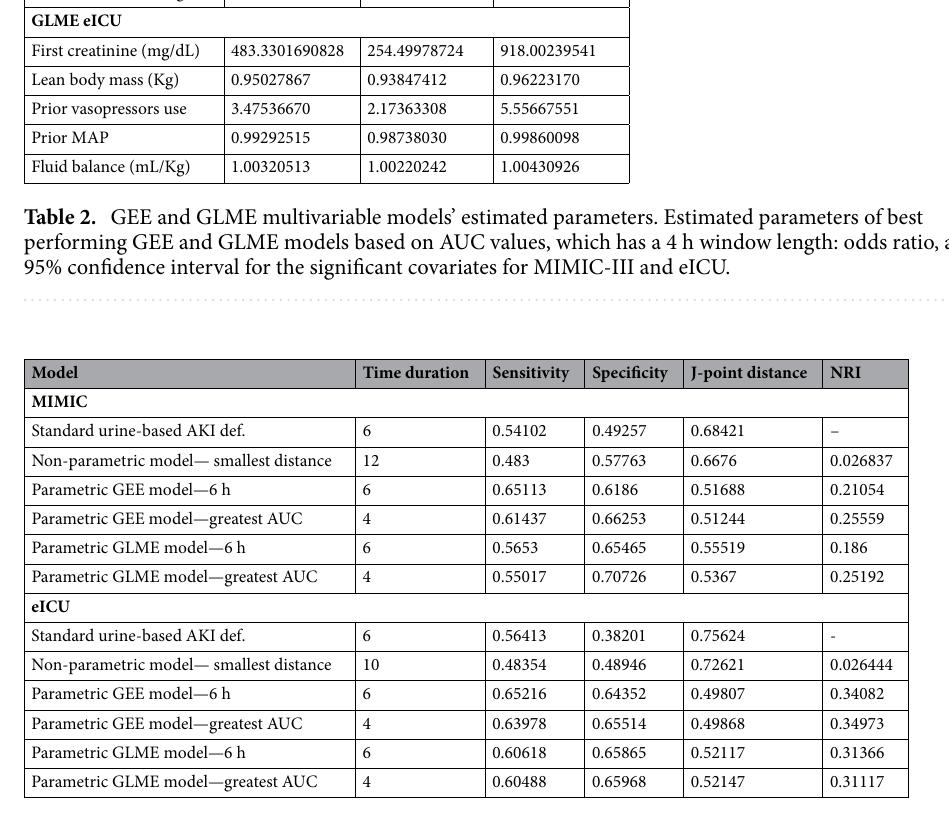
Table 3. Performance metrics across various models. Performance metrics for the standard urine-based AKI definition, best performing non-parametric model, GEE model with six hours duration, best performing GEE model, GLME model with six hours duration, and best performing GLME model. Top table is for the MIMIC- III dataset and the bottom is for